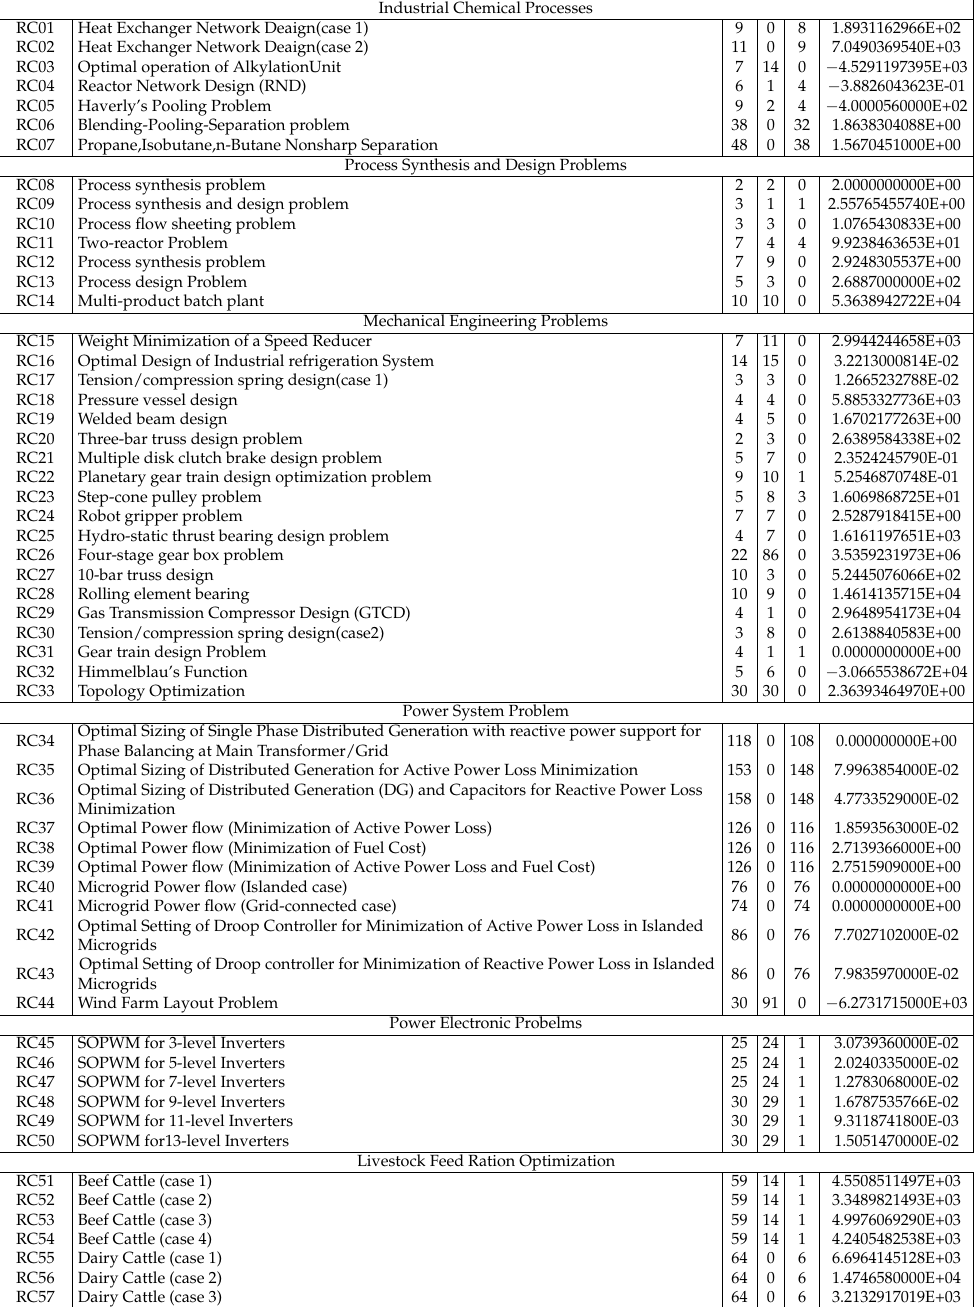
Table 7. The 57 engineering constrained optimization